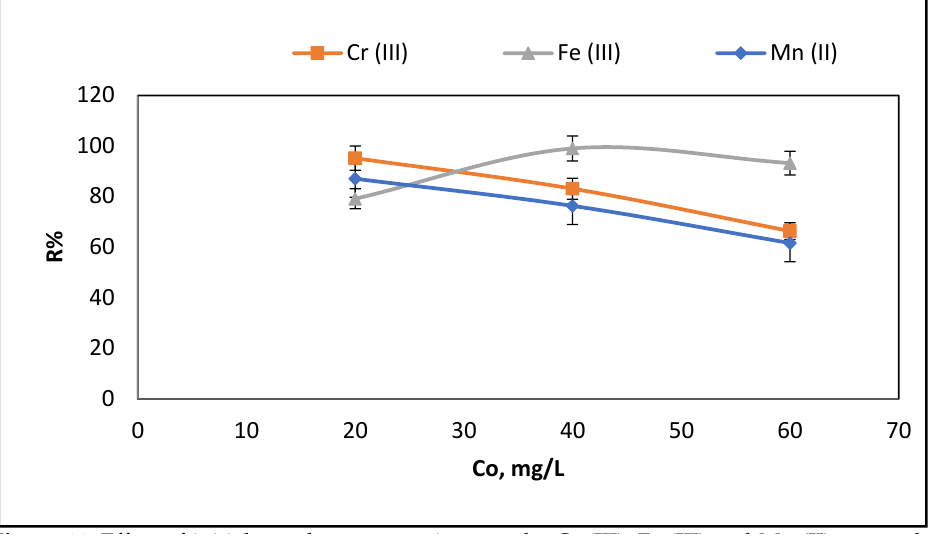
Figure 11. Effect of initial metals concentrations on the Cr (III), Fe (III) and Mn (II) removal onto Ch/g-HNTs@Zn M at 30 °C and pH 9.